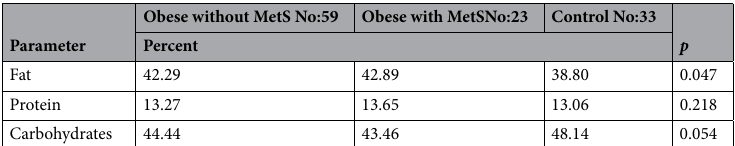
Obese without MetS No:59 Obese with MetSNo:23 Control Parameter